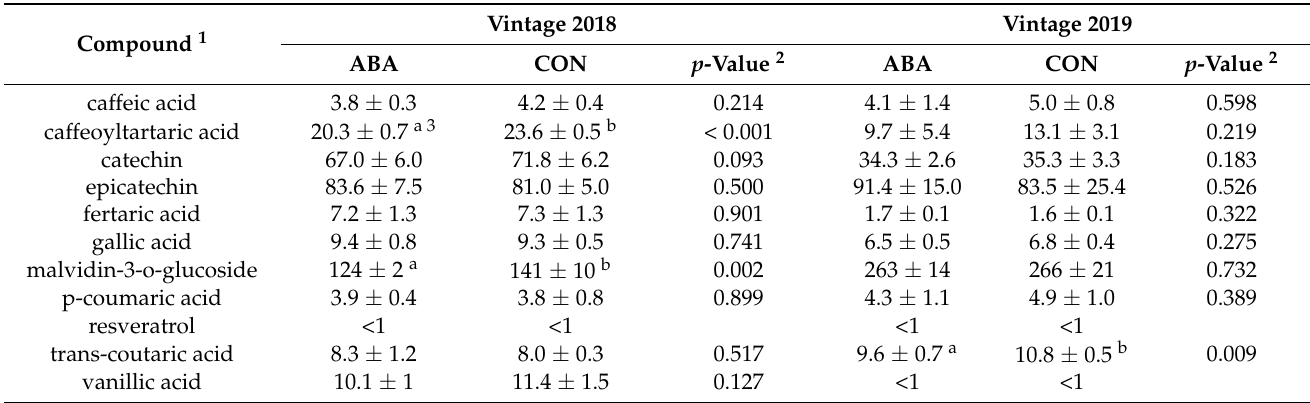
Table 1. Major phenolic compounds measured in wines from GRBV-positive Pinot noir vines under exogenous abscisic acid application (ABA) to the fruit zones and no abscisic acid control (CON) during two seasons.